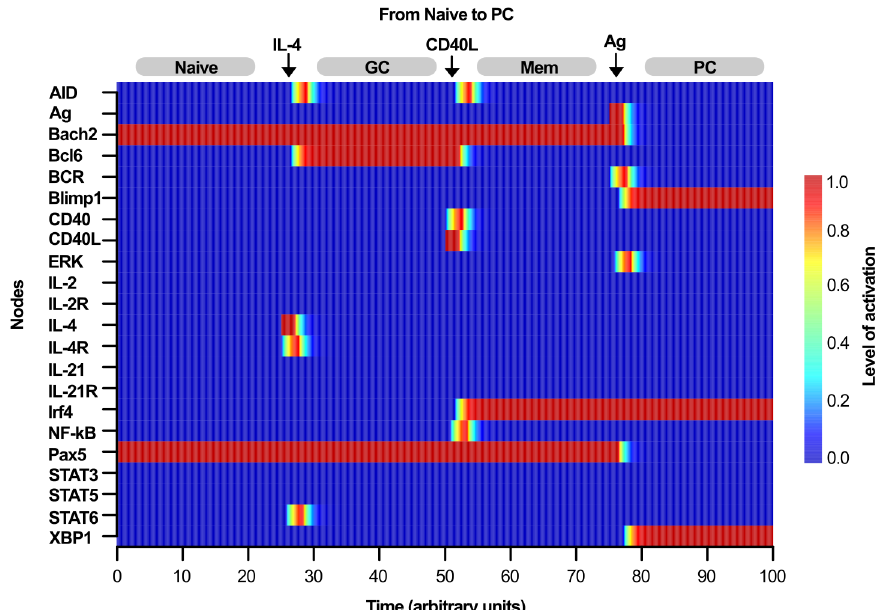
Fig 4. Differentiation from Naive to the PC cell type. The changes in the activation of all nodes of the network are shown as a heatmap which scales from blue to red as the activation level goes from 0 to 1, respectively. Extracellular signals are simulated as a burst for two or more units of time (arrows). Starting from the Naive (Bach2 + , Pax5 + ) stationary state ( t = 0 to t (cid:2) 25), the system moves to the GC attractor (Bach2 + , Bcl6 + , Pax5 + ) due to the presence of a simulated pulse of IL-4 ( t (cid:2) 25) which in turn transit to the Mem attractor (Bach2 + , Irf4 + , Pax5 + ) due to the action of CD40L ( t (cid:2) 55) and finally, Mem attractor moves to the PC state (Blimp1 + , Irf4 + ) by the presence of Ag signal ( t (cid:2)